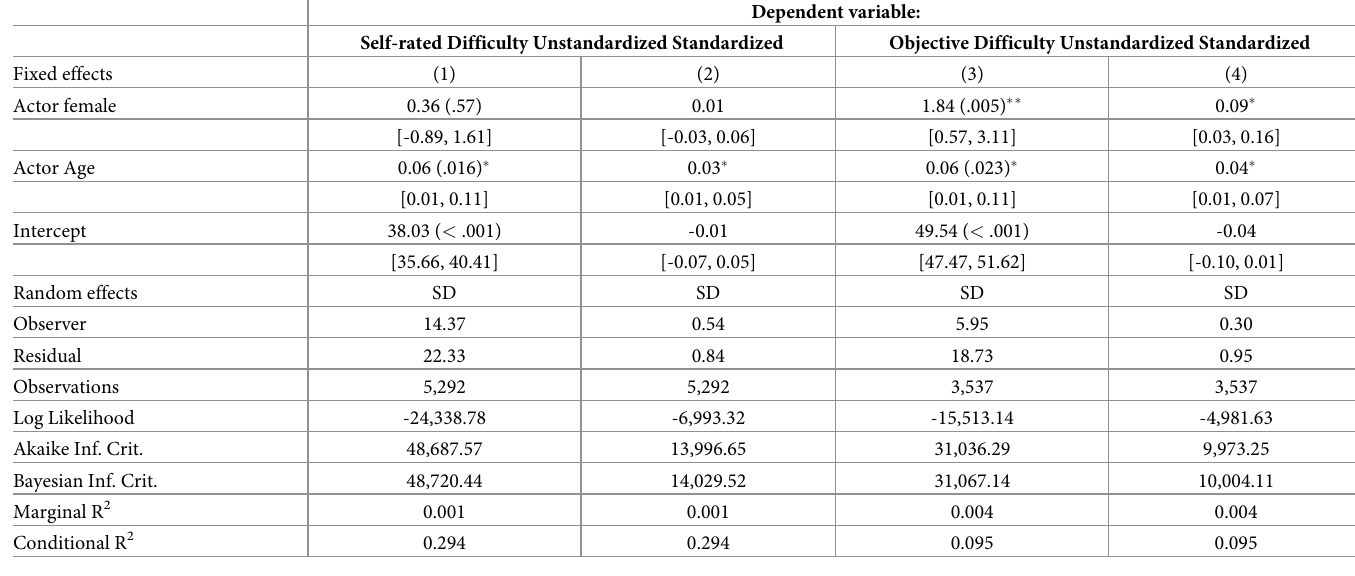
Table 1. Mixed effects models for subjective and objective difficulty predicted by actor sex and age and a random effect for observer. Exact p values are shown in the brackets next to the unstandardized estimates. 95% Confidence Intervals are shown in square brackets. Dependent